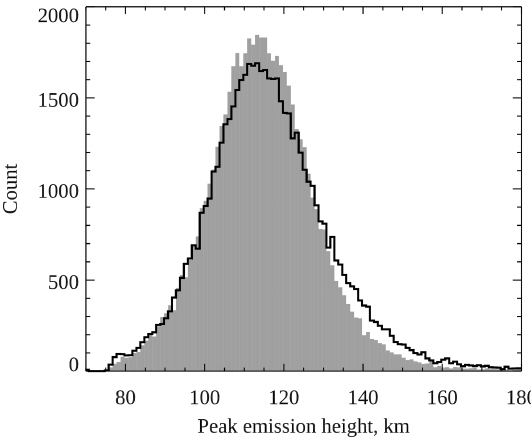
Figure 1. Histograms of observed peak emission heights for the green 557.7nm emission (grey shading) and blue 427.8nm emis- sion (black outline).